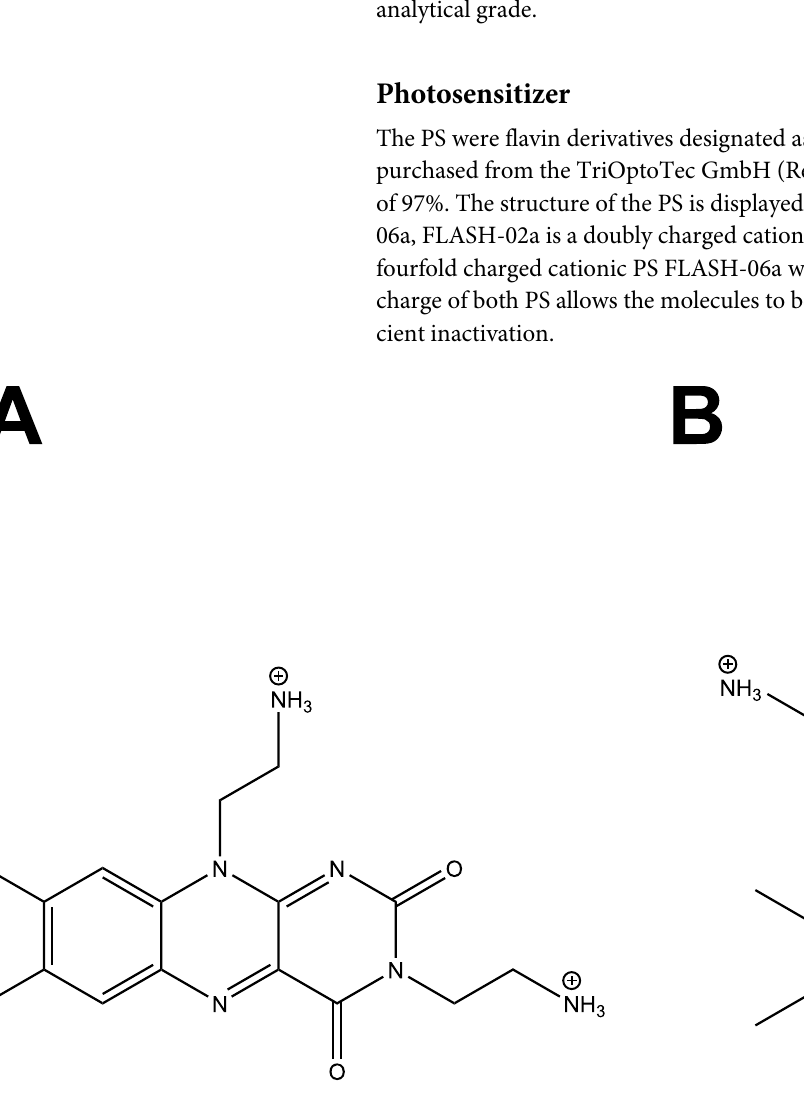
Fig 1. Structure of the used PS. (A) shows the structure of FLASH-02a, (B) shows the structure of FLASH-06a. The counterions of the substances were in both cases chloride anions.